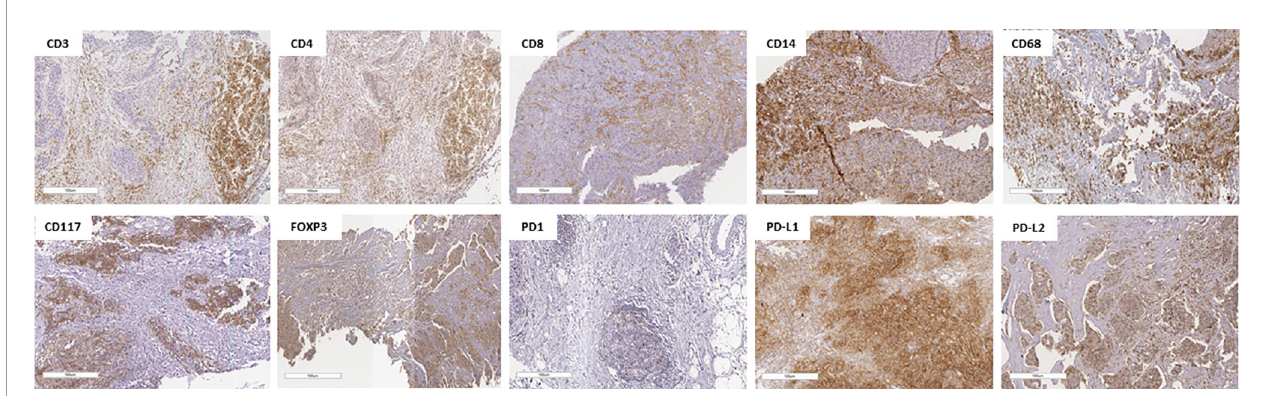
FIGURE 1 | Representative pictures of lymphocyte in fi ltration in triple-negative breast cancer core biopsy showing immunohistochemical staining of high CD3+, CD4+, CD8+, CD14+, CD68+, CD117+, FOXP3+, PD-1+, PD-L1+, and PD-L2+. The specimens are imaged at ×20 magni fi cation with a 100-μm scale on each